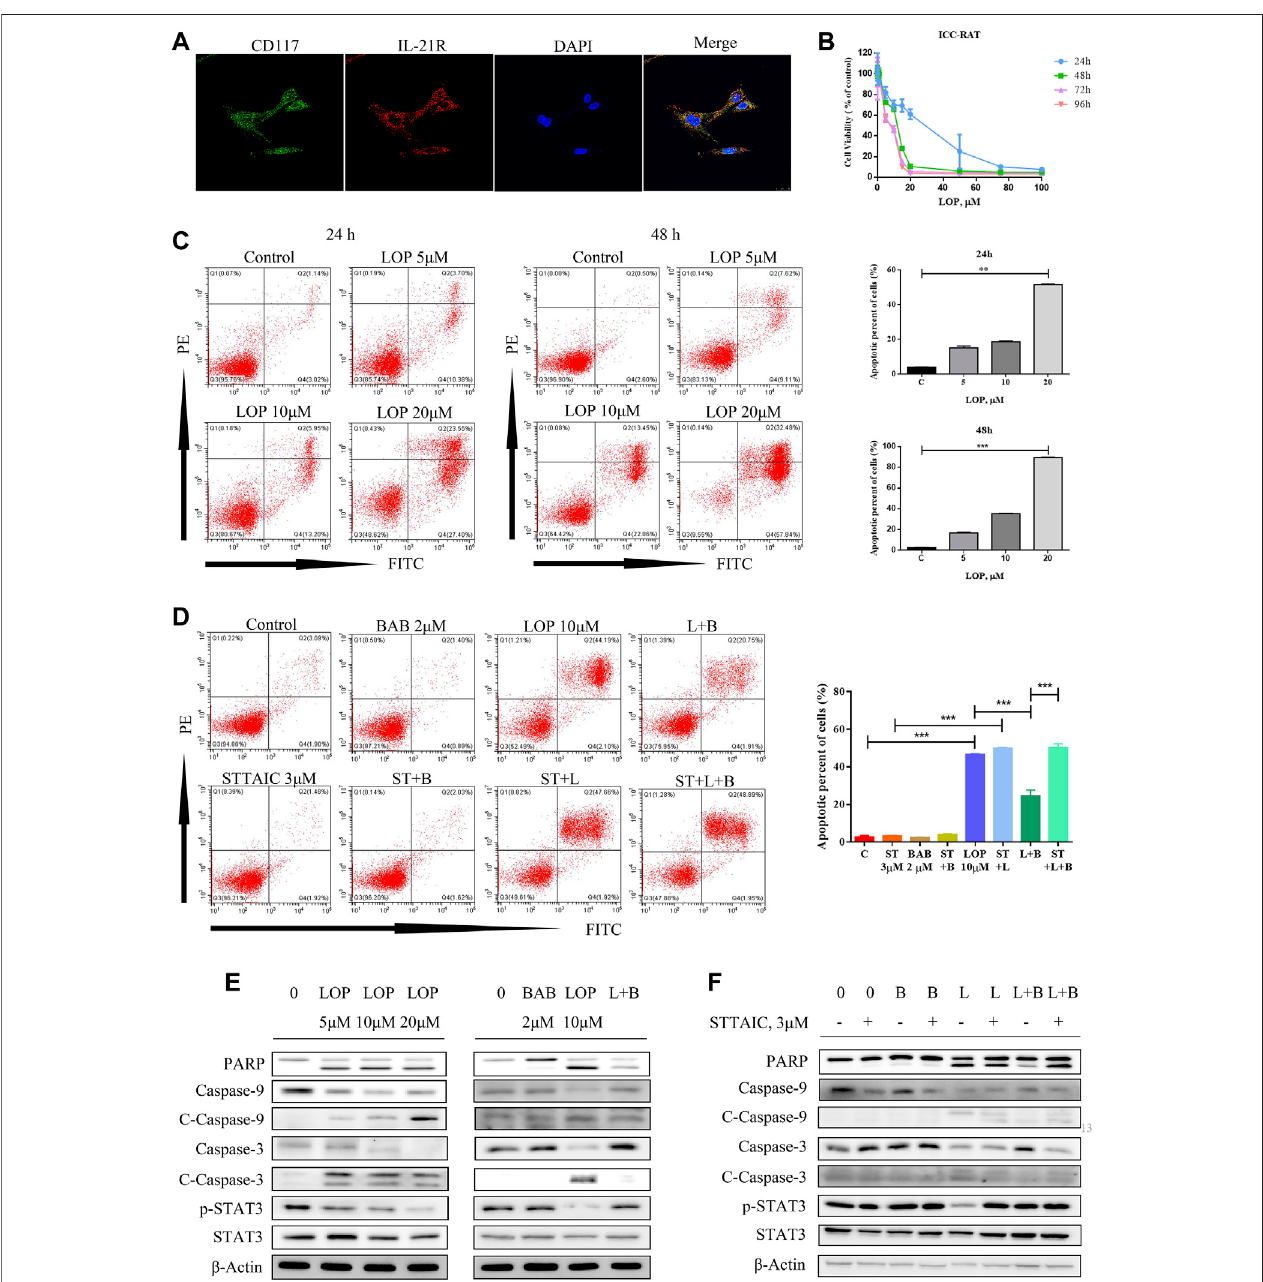
FIGURE 6 | The effect of loperamide on interstitial cells of Cajal (ICC) in rats. (A) Immuno fl uorescence was used to identify the expression of IL-21R (red) and c-kit (green) in ICC; (B) when cells were treated with different concentrations of loperamide, it can be seen that loperamide can induce ICC apoptosis in a time-concentration dependent manner, and the IC50 at 48 h is about 12 μ M; (C) fl ow cytometry was used to detect apoptosis; (D) fl ow cytometry was used to detect the effect of butyl aminobenzene (BAB) on loperamide induced apoptosis; (E) simulated cells were treated with different concentrations of BAB; (F) Western blotting was used to detect caspase pathway-related proteins. * p < 0.05, ** p < 0.005, *** p <